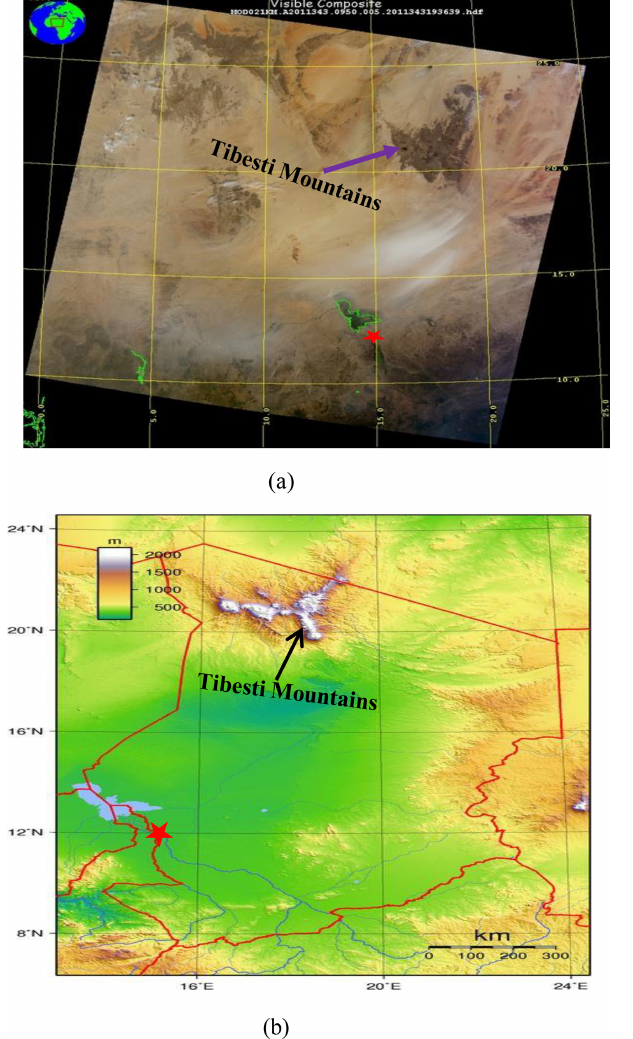
Figure 8. (a) Bodélé Depression dust storm image captured by MODIS Terra at 09:50UTC on 9 December 2011 (source: https: //ladsweb.nascom.nasa.gov). The red star indicates the surface station at N’Djamena in Chad, which captured the dust storms from 06:00UTC on 8 to 9 December 2011 (source: https://www. wunderground.com/) (Pokharel et al., 2017b). The x and y coor- dinates of this station are mentioned in Sect. 3.2.1 of the Bodélé Depression dust storm case study. (b) Topographical map of Chad (https://www.pinterest.com.au/pin/510877151474548010/, last ac- cess: 19 September 2019). The red star in this map shows sur- face station at N’Djamena in Chad, which captured the dust storms from 06:00UTC on 8 to 9 December 2011 (source: https://www. wunderground.com/) (Pokharel et al., 2017b).